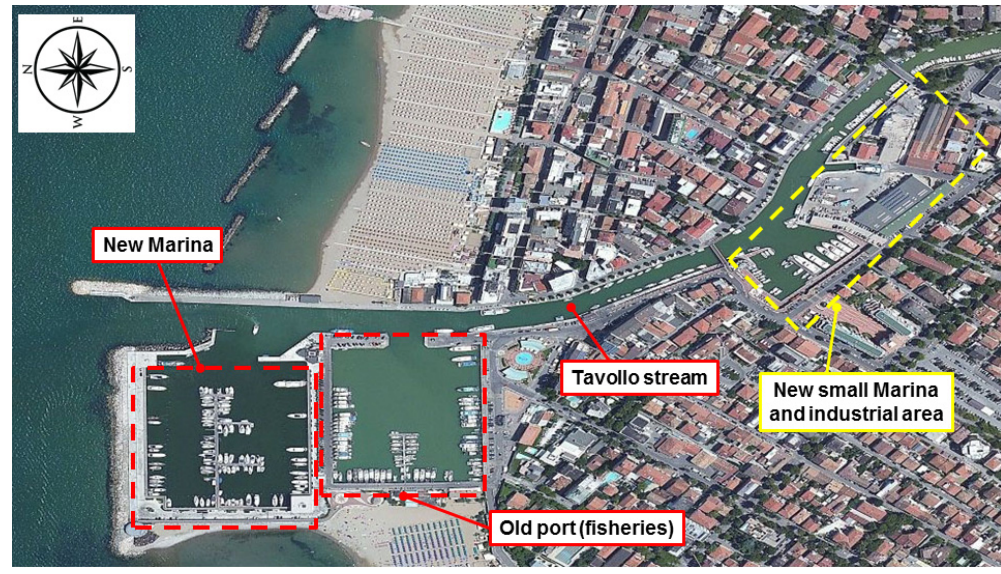
Figure 1. Aerial view of Cattolica port area.